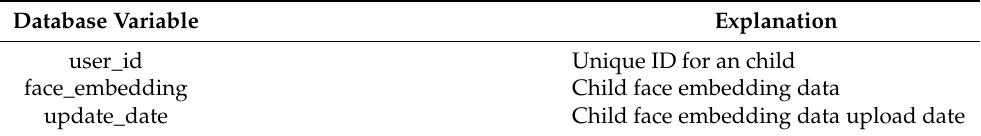
Table 4. Database